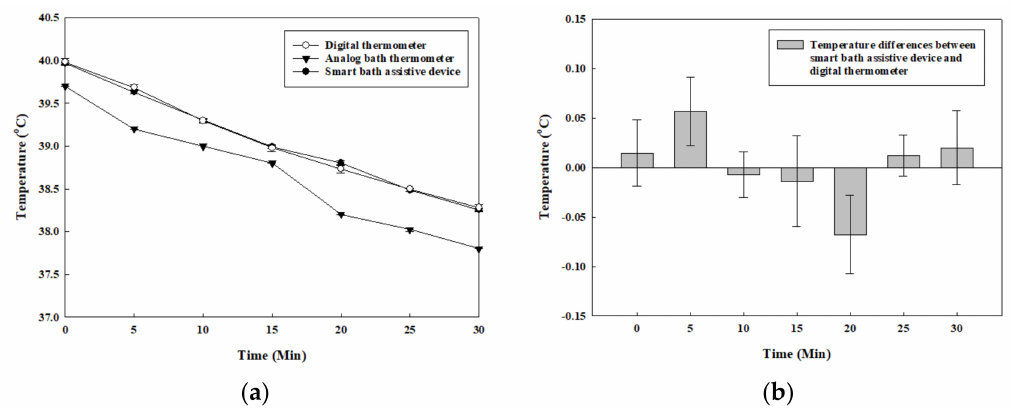
Figure 10. Graph with developed compensation algorithm for temperature measured by the proposed device: (a) water temperatures measured by the three devices; (b) di ff erences in value between the proposed device (with compensation algorithm) and digital